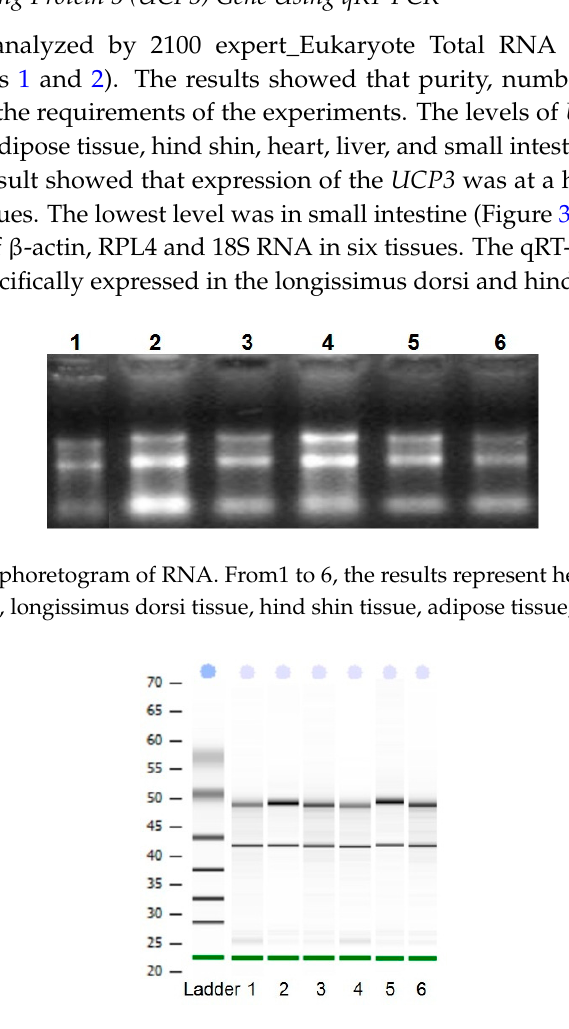
Figure 2. The 2100 biological analyzer results of RNA. From1 to 6, the results represent heart tissue, liver tissue, small intestine, longissimus dorsi, hind shin, adipose tissue, respectively.